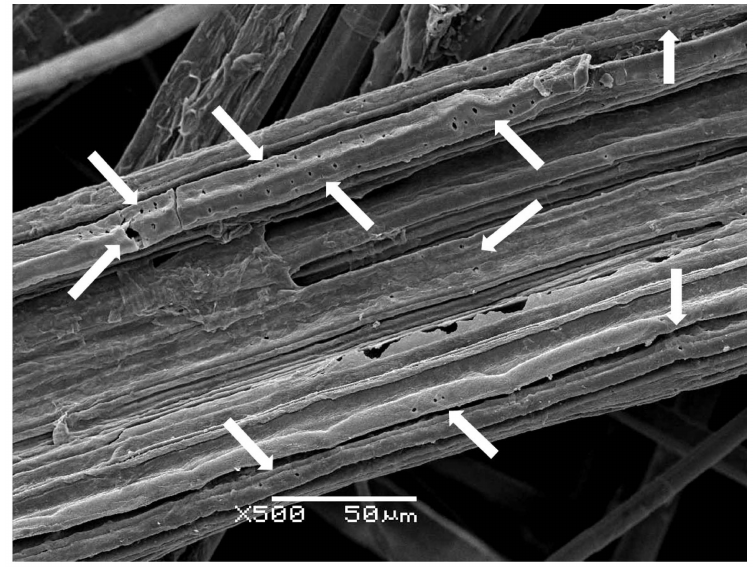
Figure 3. SEM image of the sample NW C-Ar30 taken at 10 kV and ˆ 500 magnification. Arrows mark the craters